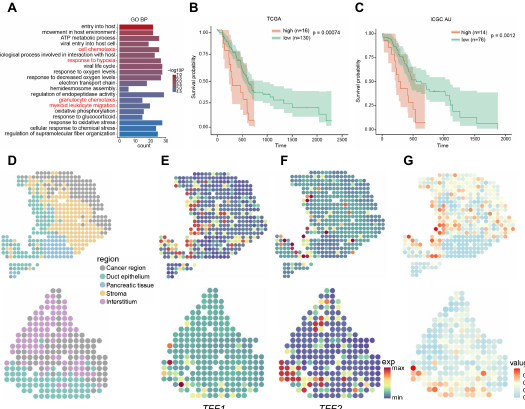
Figure 4. Analysis of up-regulated metastatic signature genes (MSGs). ( A ) Bar graph of the top p value. The x -axis shows the 20 significant Gene Ontology (GO) terms, ordered by decreasing − log 10 number of genes enriched for the corresponding GO term. The terms which were colored red were associated with metastasis. ( B , C ) Kaplan–Meier survival curves for patients in The Cancer Genome Atlas (TCGA) and AU cohort of International Cancer Genome Consortium (ICGC) datasets. ( D ) The unsupervised clustering analysis of spatial transcriptomics (ST) in pancreatic ductal adenocarcinoma (PDAC). Colors indicate the distinct regions. ( E , F ) Spatially resolved heatmaps of expression patterns for TFF1 and TFF2 . ( G ) Spatially resolved heatmaps of proportion of metastasis-featuring tumor cells (MFTC). The proportion is indicated by the